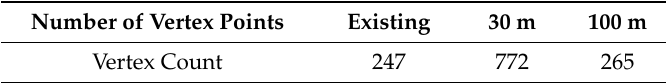
Table 7. Number of vertex points.